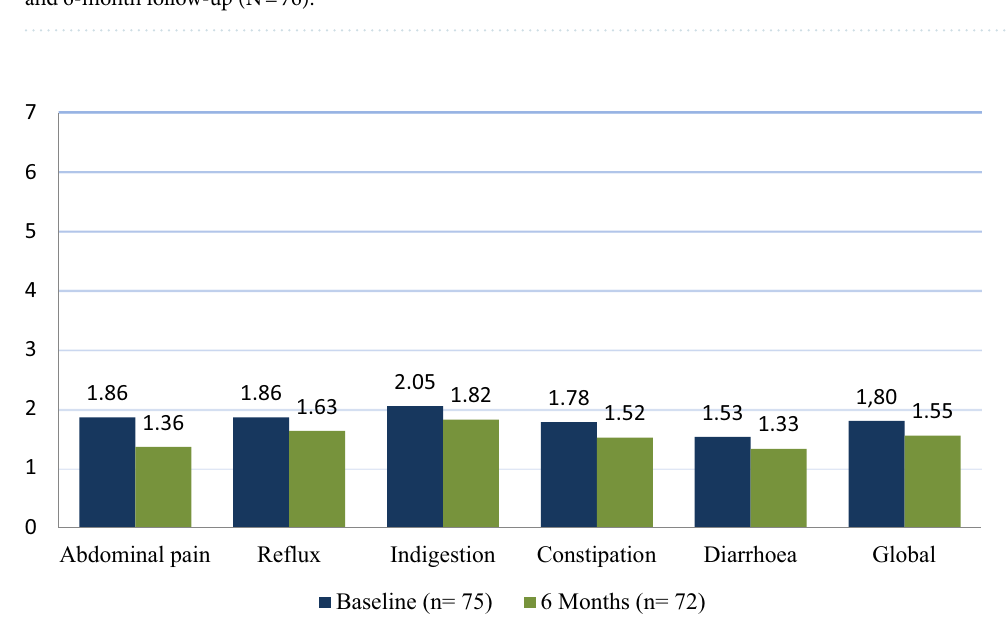
Figure 3. GSRS for the whole group across each subscale at baseline and 6-month